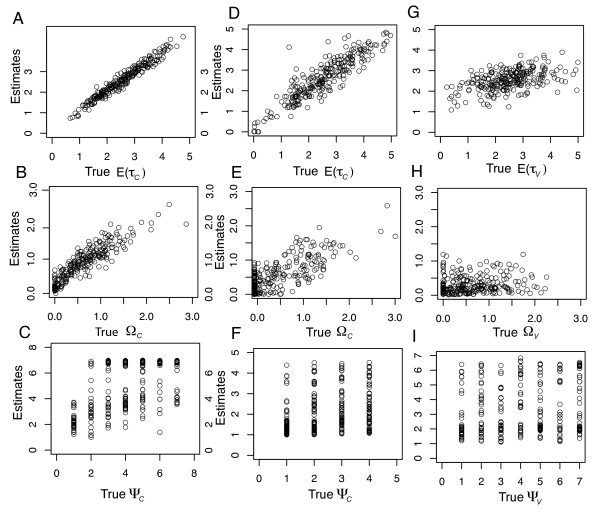
Estimator Performance: 250 true hyper-parameter values plotted against their posterior mode estimates (stage 2 model). Panels (A), (B) and (C) are given samples sizes that are identical to the Marquesas sample sizes and are obtained with the hyper-prior of Z fixed at 7 (stage 2 model). Panels (D) through (I) are given samples sizes that are identical to the Hawaiian sample sizes and are obtained with the hyper-prior of Z fixed at 4 (stage 2 model). For each estimate, tolerance was 0.001 (2,000 accepted draws) using the local linear regression algorithm.